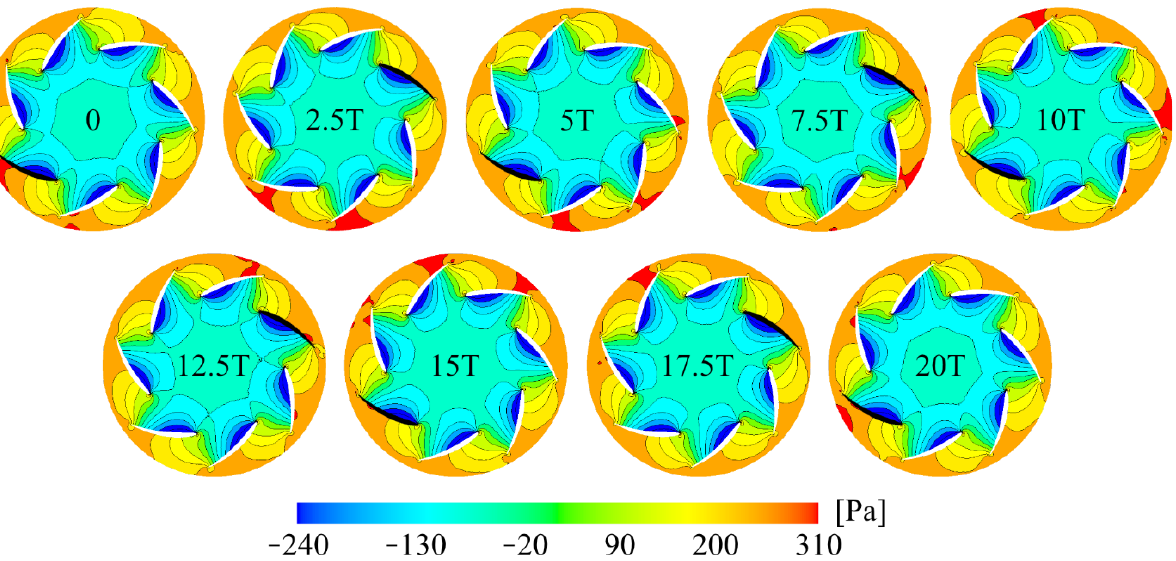
Figure 15. Snapshots of the transient pressure 𝑝 in Plane 2. Blade 3 is colored in black.